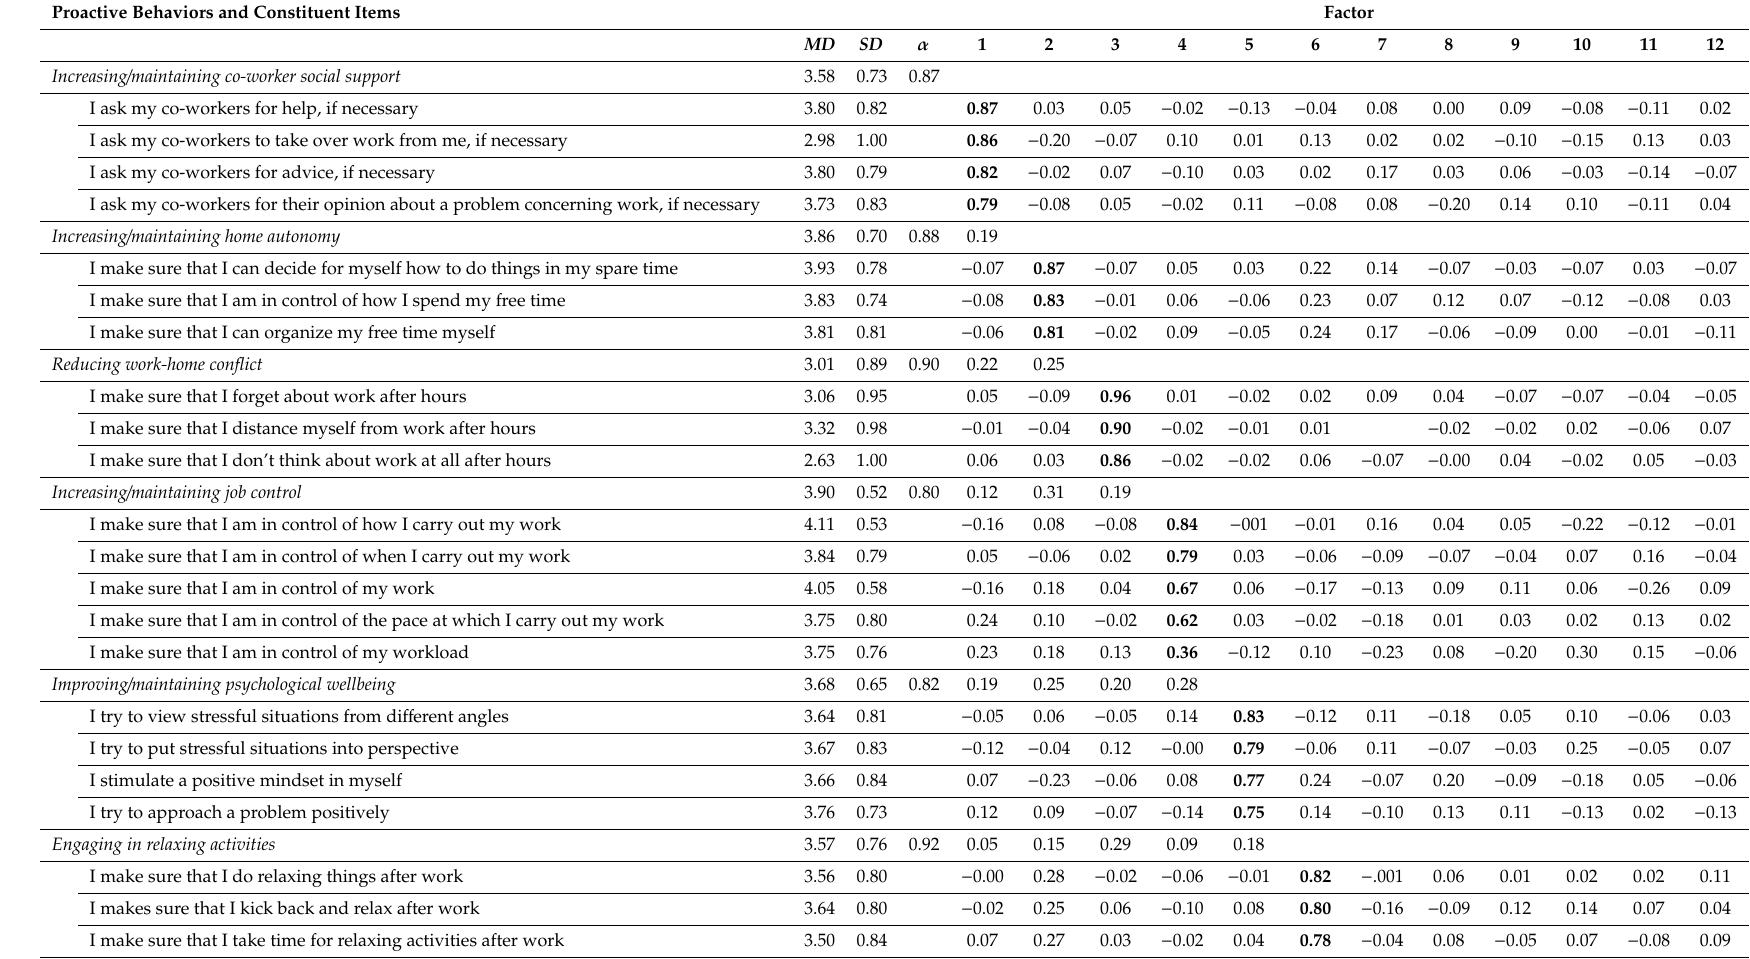
Table 2. Proactive Burnout Prevention Inventory: Items, Means, Standard Deviations, Cronbach’s Alpha, Item-Factor Loadings and Factor